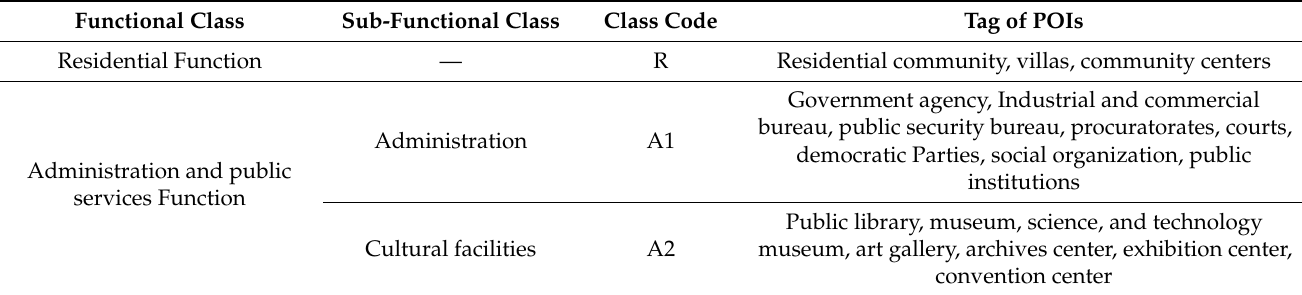
Table A1. Reclassification system of POIs to functional construction land